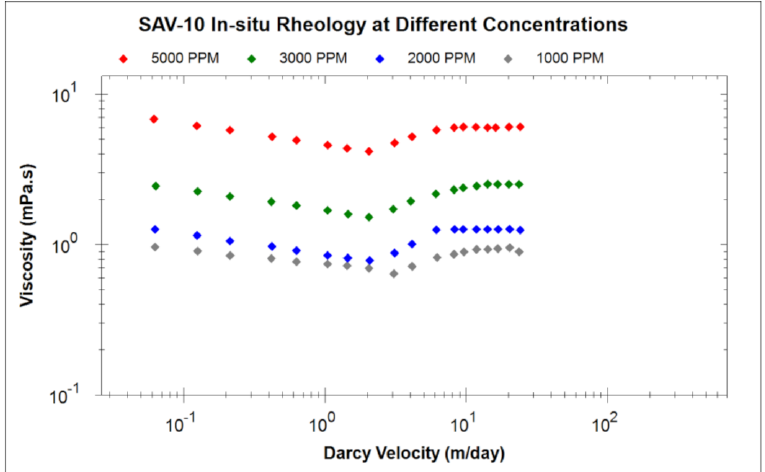
Figure 3. In situ viscosity measurements of SAV-10 at different concentration at 120 ◦ C (Modified from [20]).